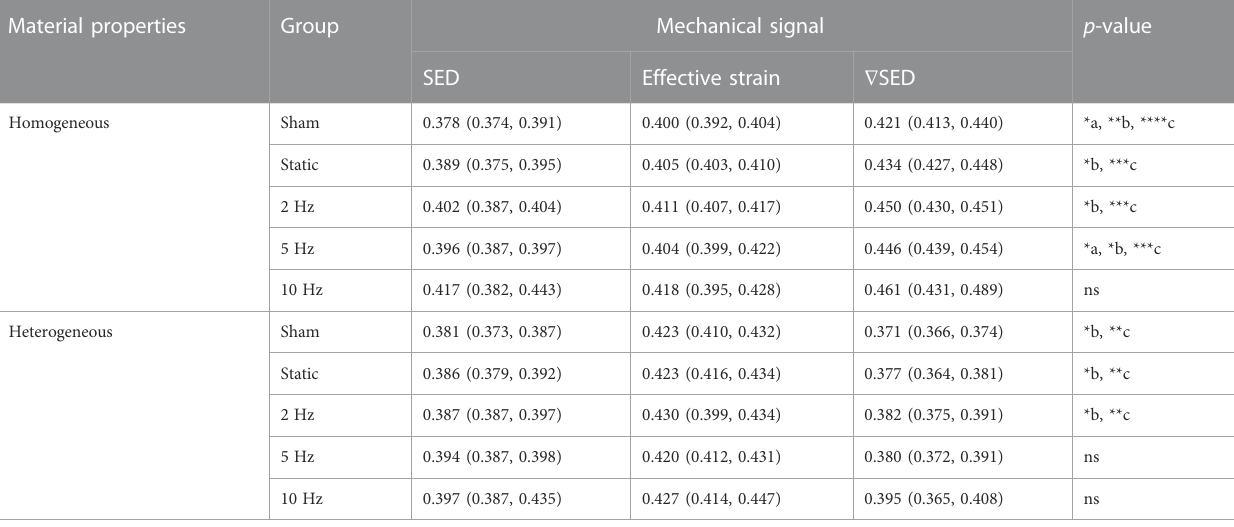
TABLE 2 Correct classi fi cation rate (CCR) for all groups, mechanical signal descriptors, and material properties analyzed for weeks 0 – 4. Data presented as “ median (IQR). ” Material